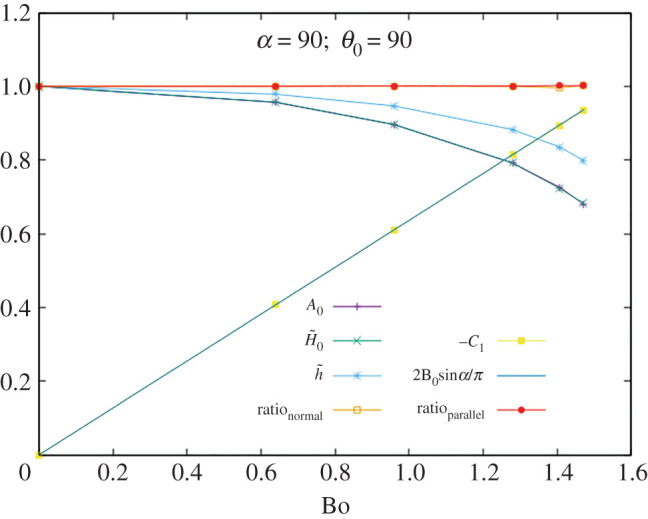
Testing the identities for α = 90° and θ0 = 90°.